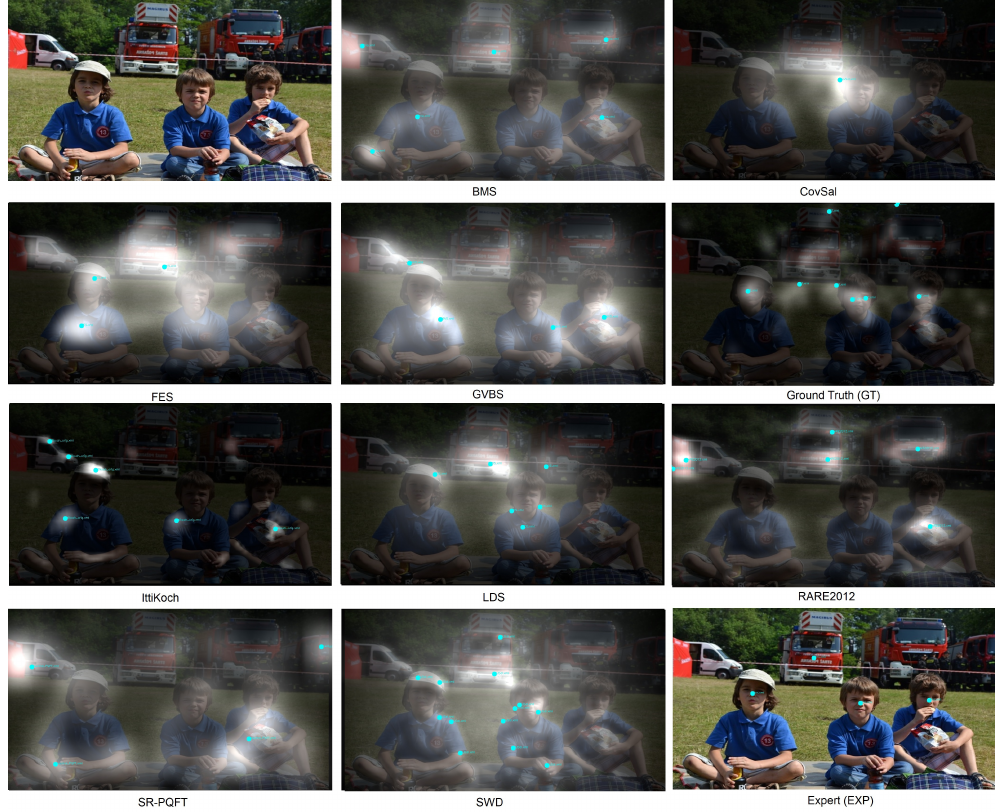
Figure 4. Exemplary image with corresponding saliency maps obtained with different methods. The targets (PFTs) are presented as cyan dots with labels on each